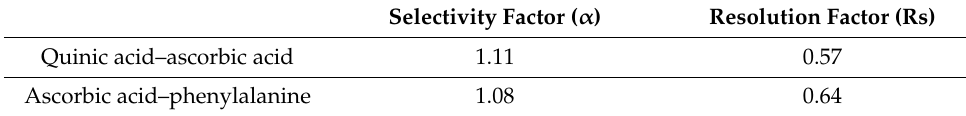
Table A2. Chromatographic parameters associated with the separation between the peaks.